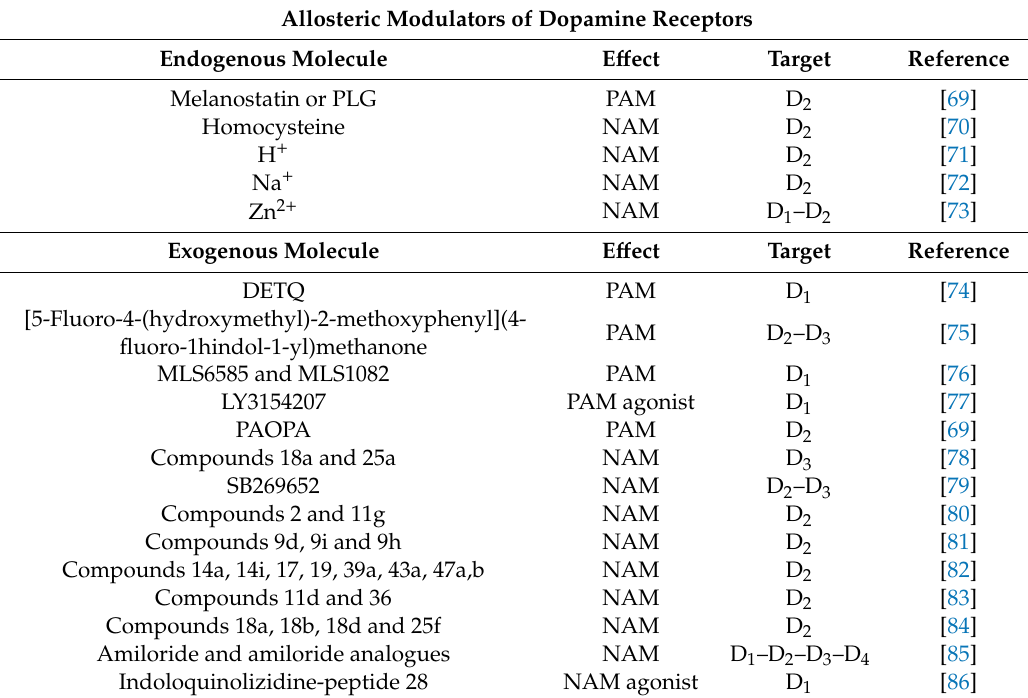
Table 2. Allosteric modulators of dopamine and serotonin